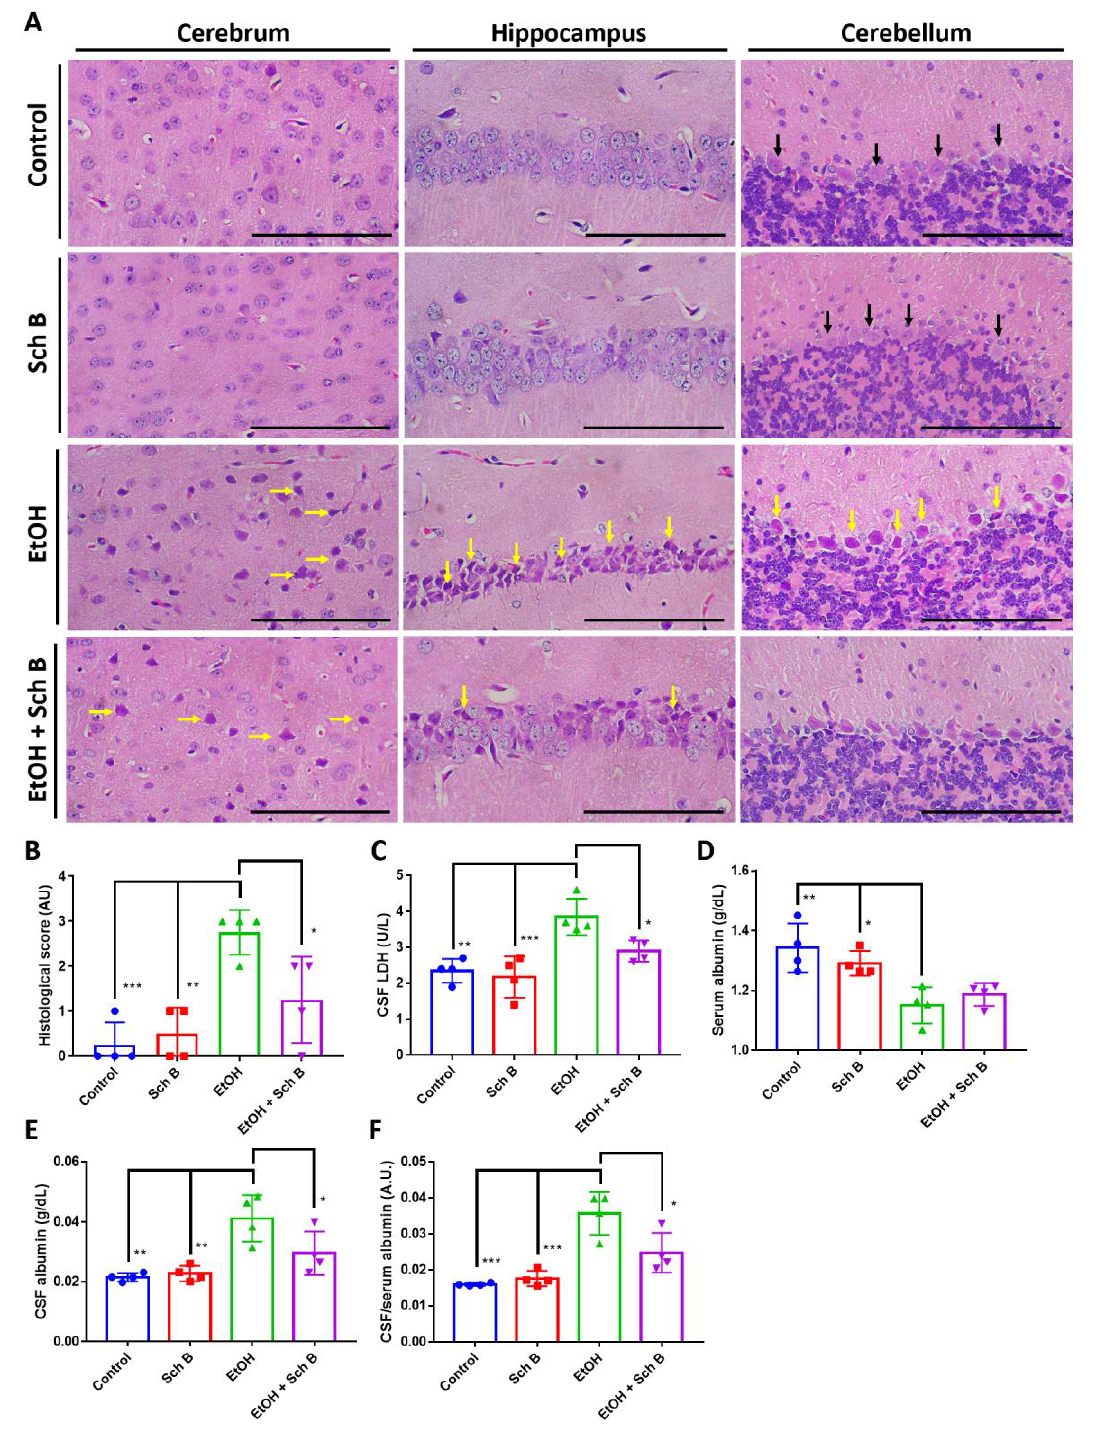
Figure 9. Schisandrin B alleviates ethanol-induced brain injuries in mice. ( A ) Representative H&E- stained histological images showing the brain pathology of mice. Neuronal cell death (yellow arrows) was seen in ethanol-treated mice, which improved after Sch B treatment. Black arrows represent normal Purkinje fibers. Scale bar corresponds to 200 μm. ( B ) Histological scores based on the histological slides from ( A ). Concentrations of ( C ) CSF LDH, ( D ) serum albumin, ( E ) CSF albumin, and ( F ) CSF-to-serum albumin ratio. n = 4 mice. Results are expressed as mean ± SD. * p < 0.05, ** p < 0.01, and *** p < 0.001.